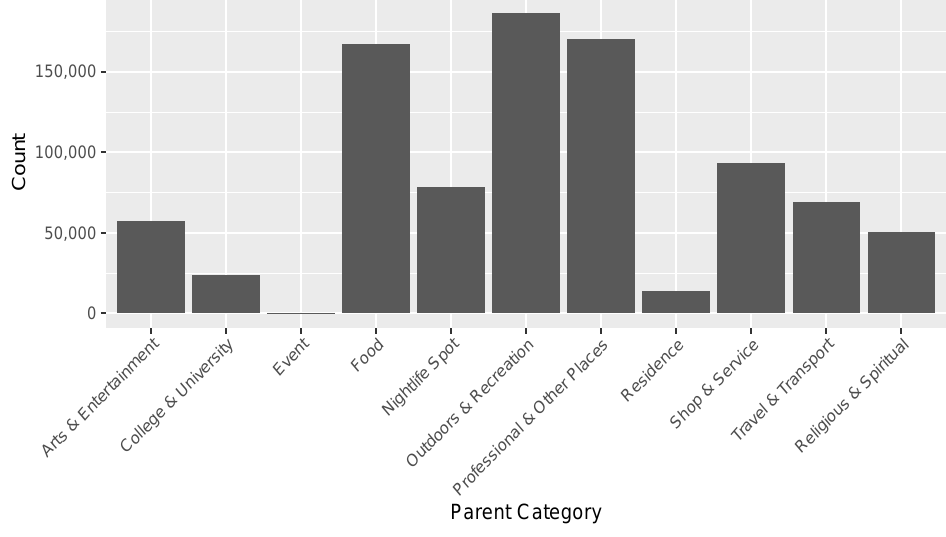
Figure 1. Frequency of Venue Parent Categories for Meetups Across the United